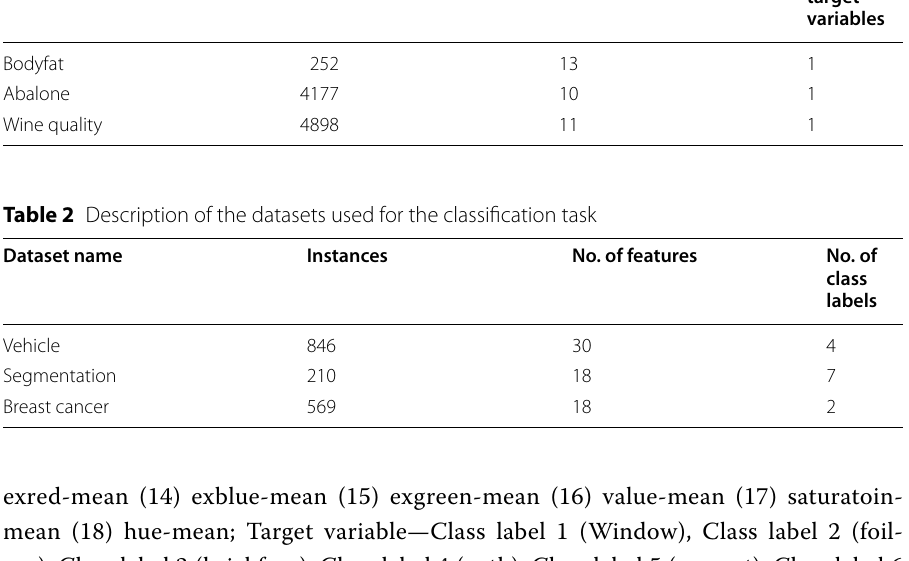
Table 1 Description of the datasets used for regression task Dataset name